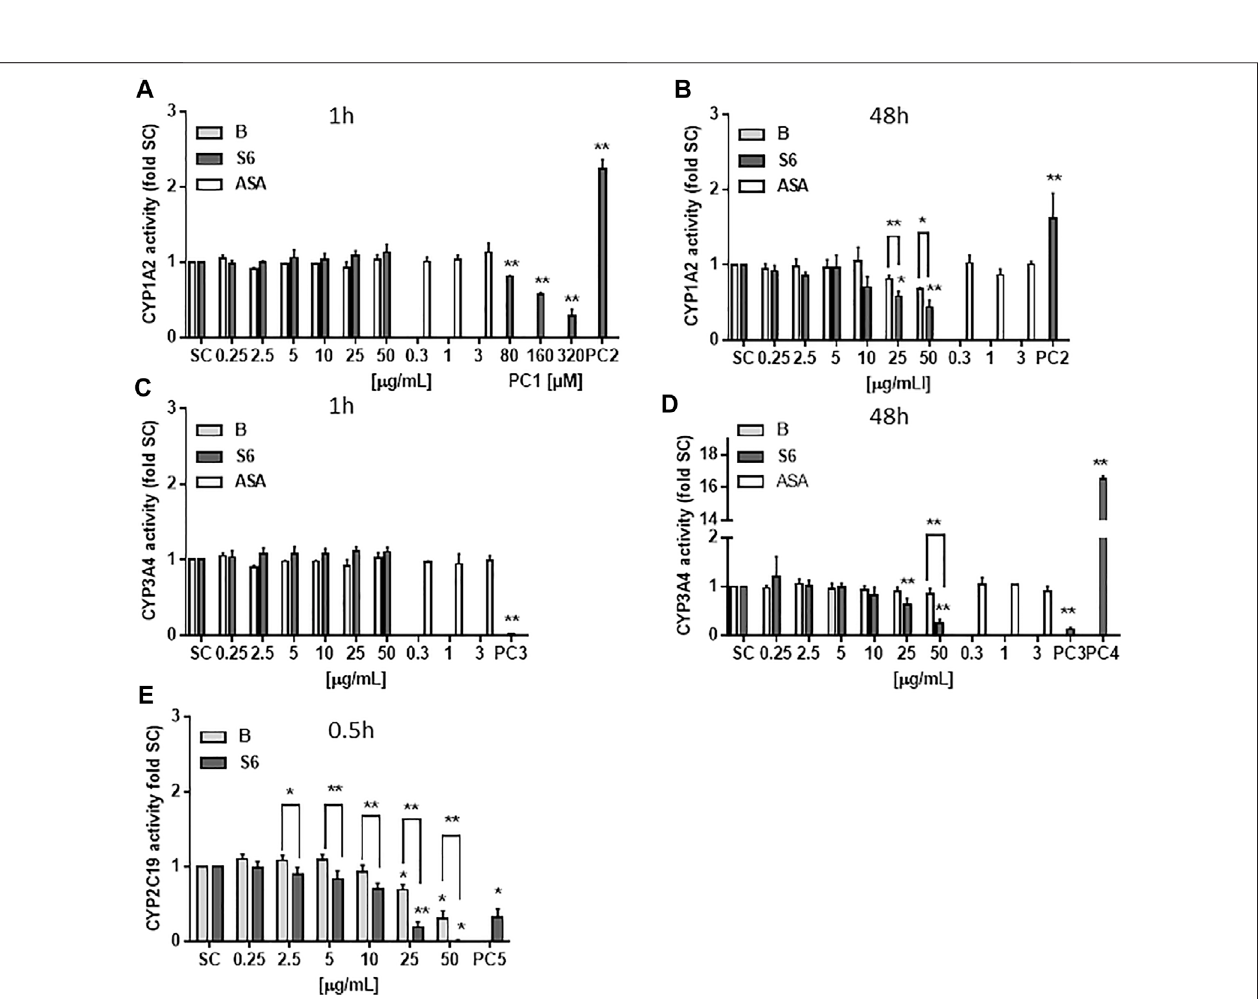
FIGURE 1 | CYP450 enzyme activity quanti fi cation after treatment with Salix cortex extracts using a luminescent method. (A – D) Differentiated HepaRG cells were exposed to extracts for 1 or 48 h before analysis. (E) CYP2C19 enzyme activity was analysed in a cell-free assay after 0.5 h incubation of extracts with a human recombinant CYP2C19 enzyme, followed by analysis. Positive control (PC): 320 μ M naringenin (CYP1A2 inhibition, PC1), 50 μ M omeprazole (CYP1A2 induction, PC2), 10 μ M rifampicin (CYP3A4 inhibition, PC3), 10 μ M ketoconazole, (CYP3A4 induction, PC4), and 22.6 μ M troglitazone (CYP2C19 inhibition, PC5). ASA, acetylsalicylicacid.Thevaluesarepresentedasmeans+SD(CYP1A21and48 h,n (cid:1) 3;CYP3A41 h,n (cid:1) 3,48 hn (cid:1) 4;CYP2C19n (cid:1) 3).Ordinaryone-wayANOVAwas used forstatisticalanalysis,followedbyaDunnetttest.Signi fi cancewasevaluatedbetweenextractsandsolventcontrol(a.d.)aswellasbetweenextractS6andB.* p > 0.05, ** p >